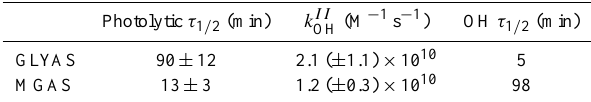
Table 1. Estimated atmospheric half-life ( τ 1 / 2 ) of Imine BrC aris- ing in the glyoxal–ammonium sulfate (GLYAS) and methylglyoxal– ammonium sulfate (MGAS)